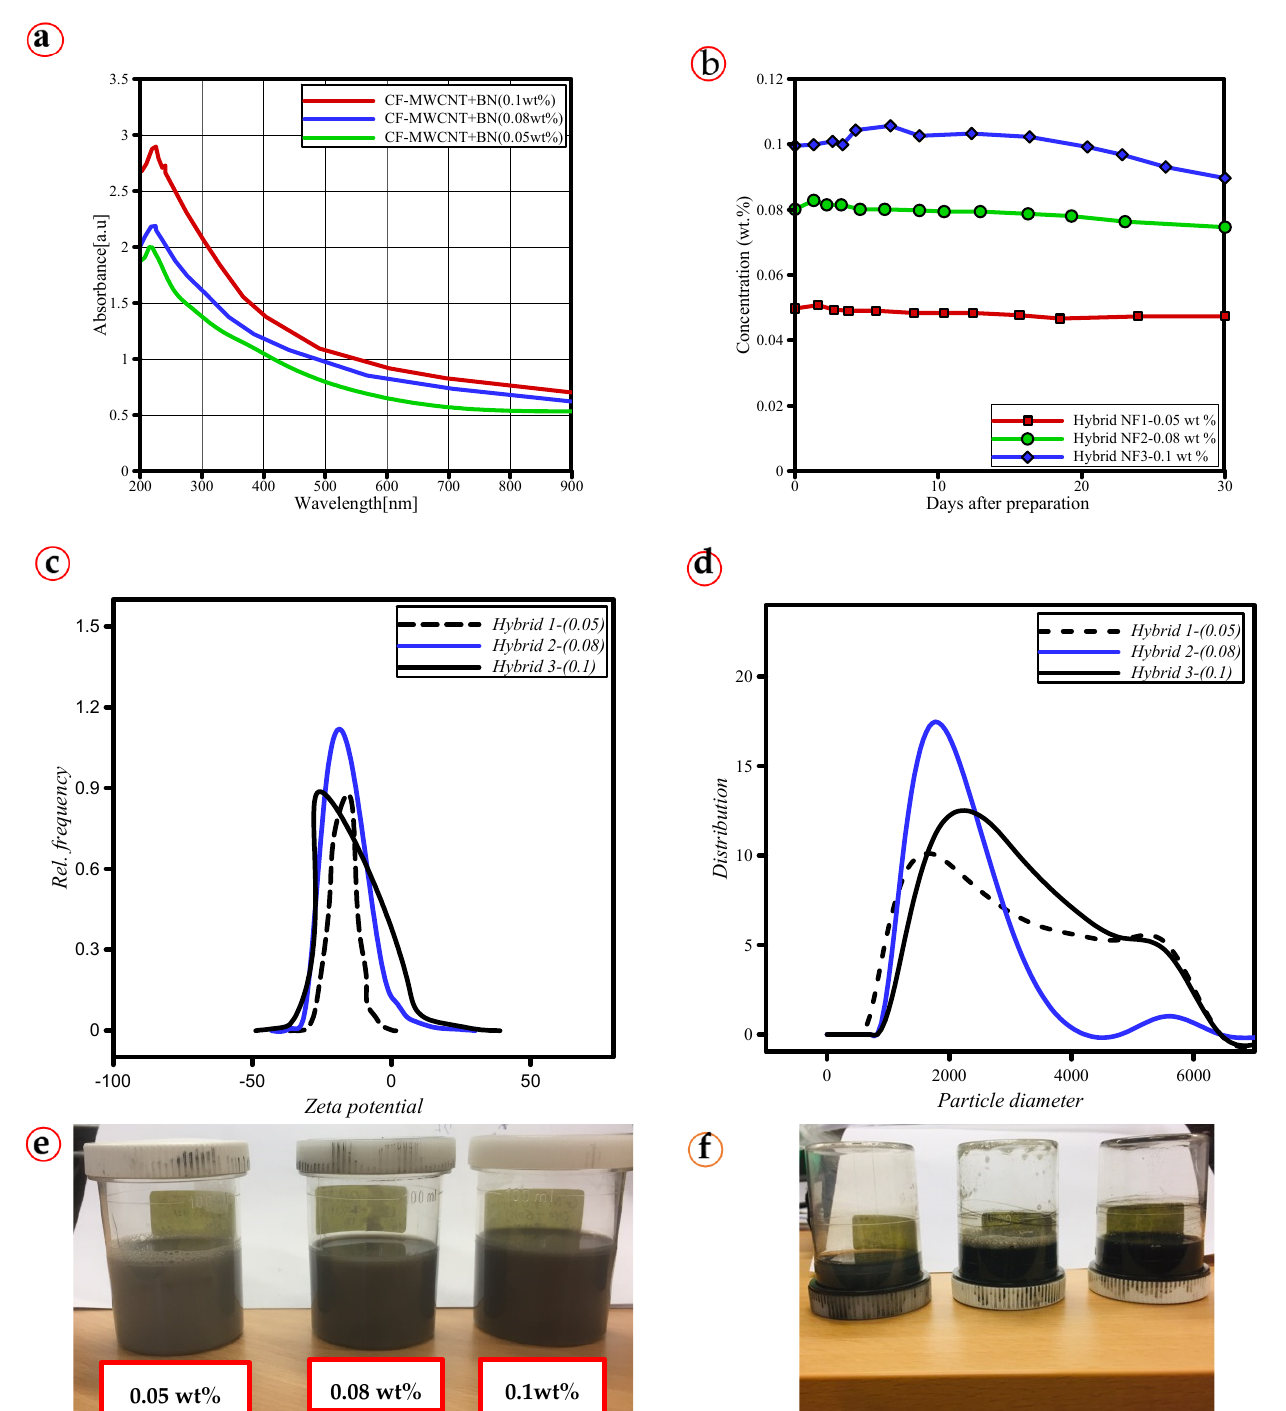
Figure 6. ( a ) Ultraviolet–visible spectrophotometry of functionalized water-based hBN/CF-CNTs hybrid nanofluid. ( b ) Difference in the relative weight concentration of CF-CNTs with hBN as a position of time for 30 days. ( c ) Zeta potential distribution after 20 days. ( d ) Particle size distributions after 20 days. ( e ) Hybrid of CF-CNTs with hBN after preparation. ( f ) Hybrid of CF-CNTs with hBN after 30 days.